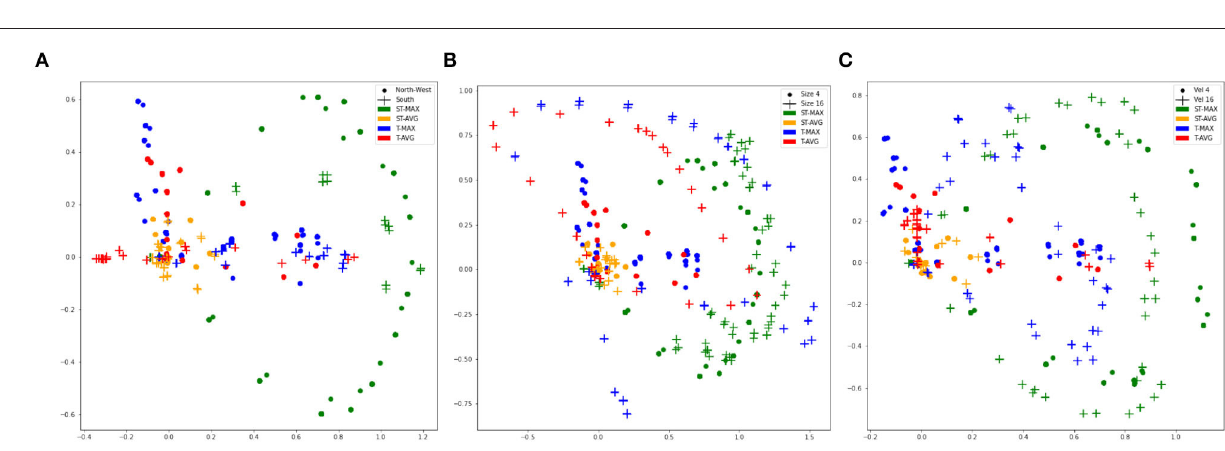
FIGURE 5 | Test on pooling’s representation power in the case of (A) movement in different directions. (B) Different target dimensions. (C) Different velocities. When fixed we refer to Direction NW, Velocity of magnitude 4 and Target dimension of magnitude